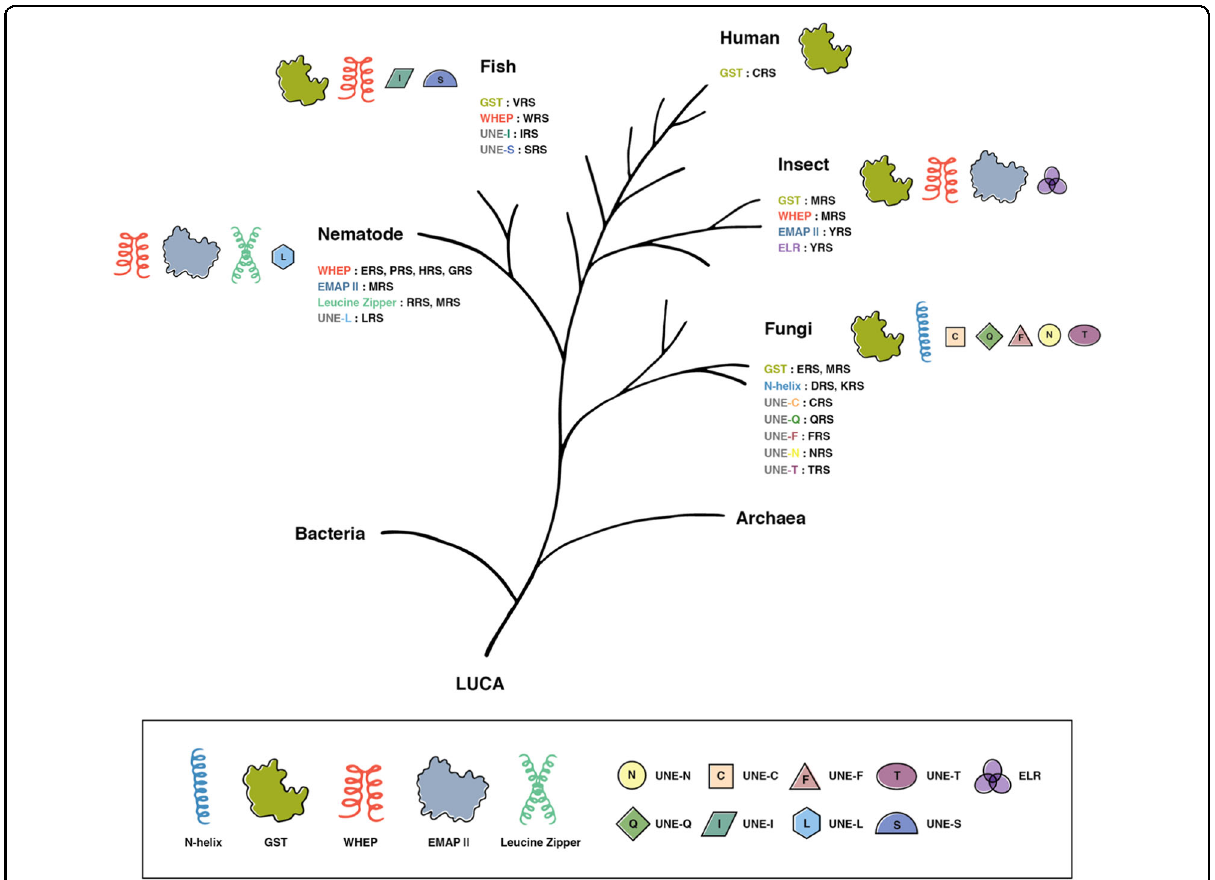
Fig. 1 Newly acquired domains and motifs in ARSs during the evolutionary process. During evolution, aminoacyl-tRNA synthetase have acquired new domains, allowing for an increase in the complexity of organisms in a particular phylogenetic group. Importantly, with the exception of MRS, these domains or motifs have been irreversibly retained by their respective tRNA synthetase until the evolution of humans. As a result, each aminoacyl-tRNA synthetase in humans has all of the newly acquired domains. Each of these domains imparts speci fi c new functions that are more complex than simple aminoacylation, which was the original function of these enzymes. The model species used are: Homo sapiens , Danio rerio , Drosophila melanogaster , Caenorhabditis elegans , and Saccharomyces cerevisiae . LUCA last universal common ancestor, N-helix N-terminal amphiphilic helix, GST glutathione S -transferase (GST)-like domain, EMAPII endothelial monocyte-activating polypeptide